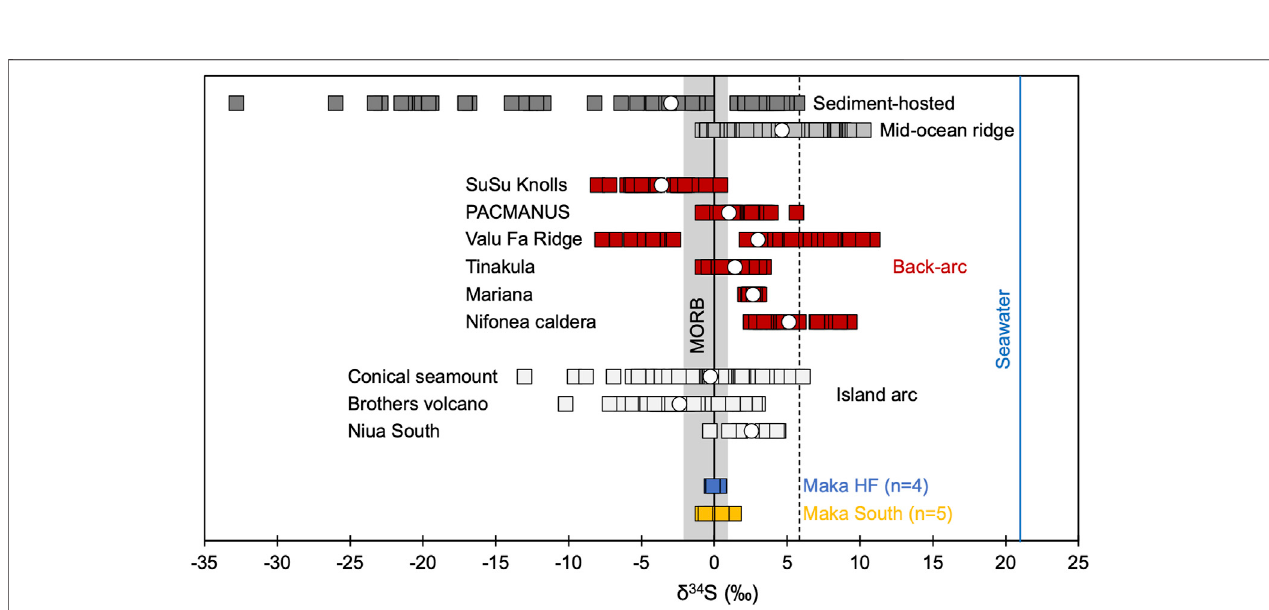
FIGURE 6 | Comparison of δ 34 S values in hydrothermal sulphides from Maka with other mid-ocean ridge, back-arc and arc related hydrothermal systems. Reference data as listed in Supplementary Table S8 in the supplementary material. The grey fi eld re fl ects the compositional range of MORB ( − 1.9 – 0.8 ‰ , SupplementaryTableS8 ),thedashed lineistheaverage δ 34 Svalueofglobalarcvolcanicrocks(5.8 ± 4.0 ‰ , SupplementaryTableS11 )andthebluelineisthe δ 34 S composition of modern seawater ( ∼ 21.2 ‰ ; Tostevin et al.,